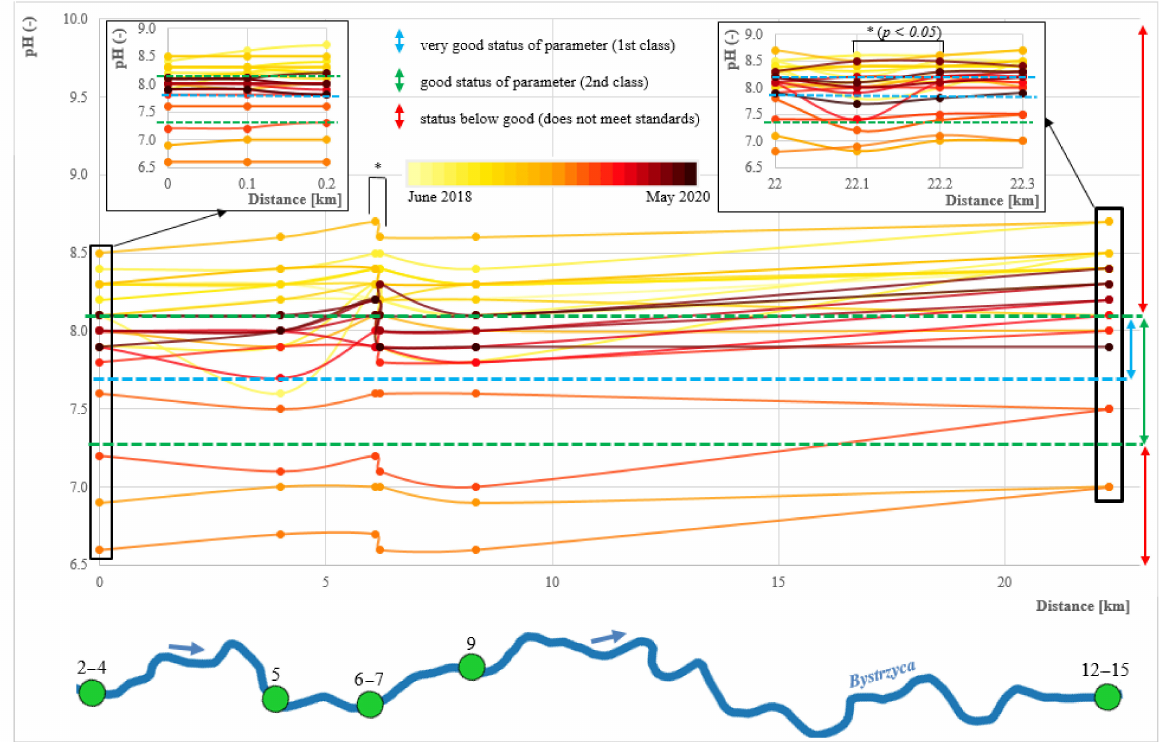
Figure A4. Temporal and spatial variability of pH at the tested measurement points, including the physicochemical condition of the parameter and statistical significance within the Sadowice, Skałka, and Marszowice HPs ( p <